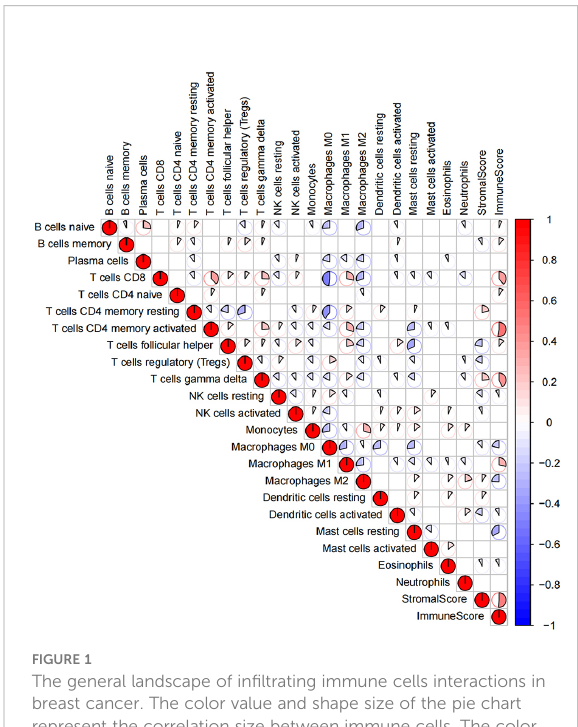
FIGURE 1 The general landscape of in fi ltrating immune cells interactions in breast cancer. The color value and shape size of the pie chart represent the correlation size between immune cells. The color bar shows the positive and negative values of the